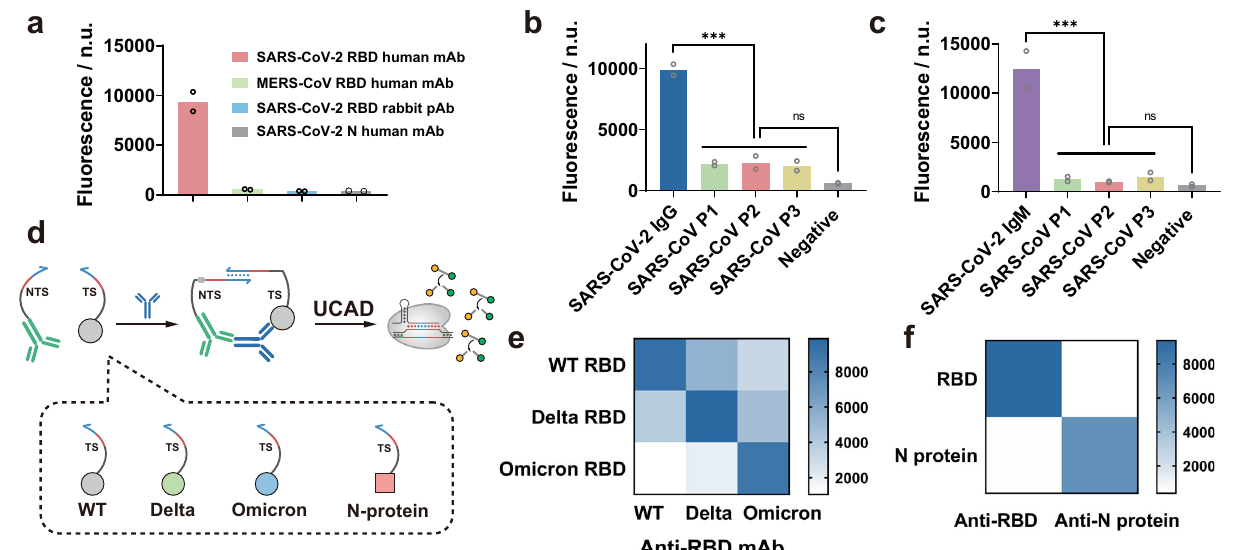
Fig. 2 | Speci fi city and modularity ofUCAD.a Detection of thetarget anti-human RBD and closely related nontargeted anti-MERS-CoV spike protein RBD human mAb (clone: m336), anti-SARS-CoV-2 nucleocapsid (N) protein human mAb, and anti-SARS-CoV-2 spike protein RBD rabbit pAb at a concentration of 10fM using UCAD. Each sample was measured twice in two independent experiments. b , c Evaluation of the speci fi city of UCAD for anti-RBD IgG ( b ) and IgM ( c ) against anti-SARS-CoVinclinicalserafromthreeSARSpatientsin2003.Eachserumsample was measured twice in two independent experiments. The UCAD signals of anti- SARS-CoV positive sera were signi fi cantly lower than the anti-SARS-CoV-2 positive